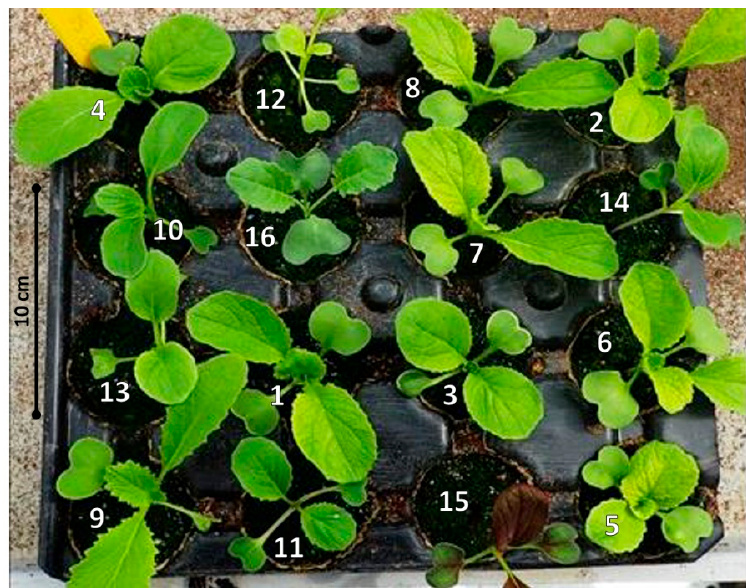
Figure 1. Photograph of a tray used for the plant preference experiment under natural infestation conditions. Numbers indicate cultivars (see Table 1). In this tray, plants 16, 7, 1 and 3 are central and all the others are